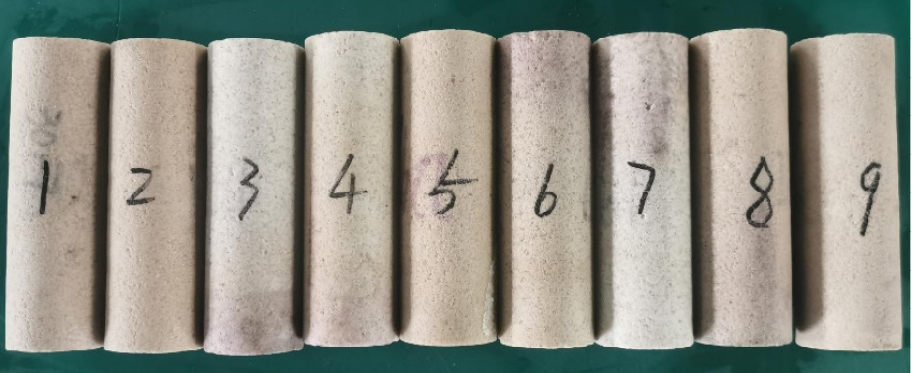
Figure 1. Cores used in the experiments.